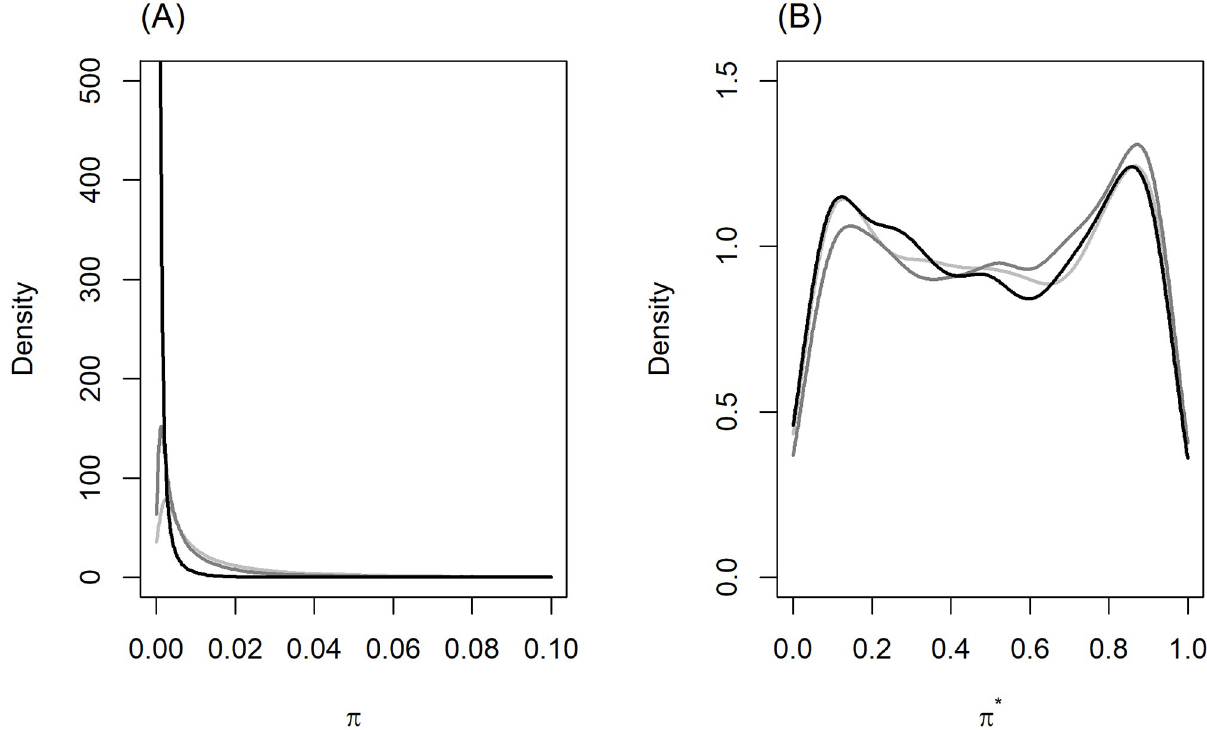
Fig 1. Distribution of simulated probabilities with imbalance ratios 1:50 (black), 1:100 (dark grey), and 1:1000 (light grey), under COR-24. (A) Original imbalanced datasets (B) Balanced datasets based on response-based downsampling.